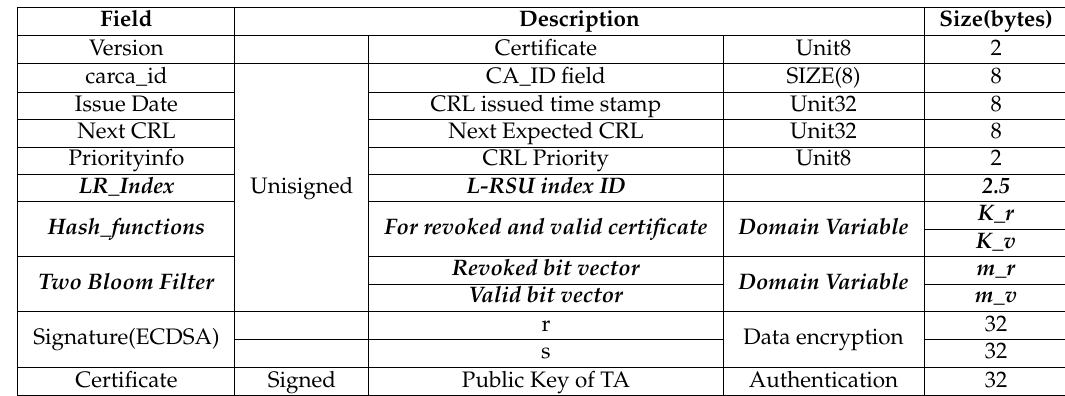
Table 3. Regional CRL format.